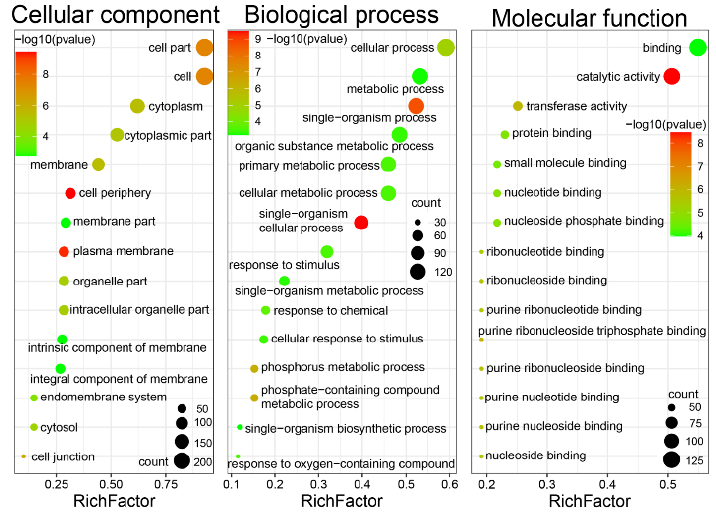
Figure 4. GO enrichment analysis of DE − genes targeted by DE − miRNAs in GZ511 vs. GZ611. The top 15 GO terms from each category are presented.